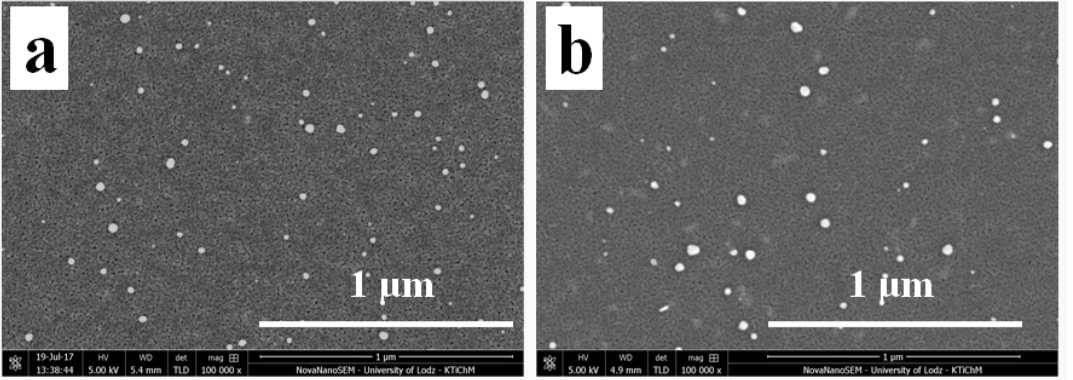
Figure 6. The morphology of TiO 2 -AgNS ( a ) and the area of TiO 2 in the TiO 2 -GO-AgNS coating ( b ) at a magnification of 100,000 ×.